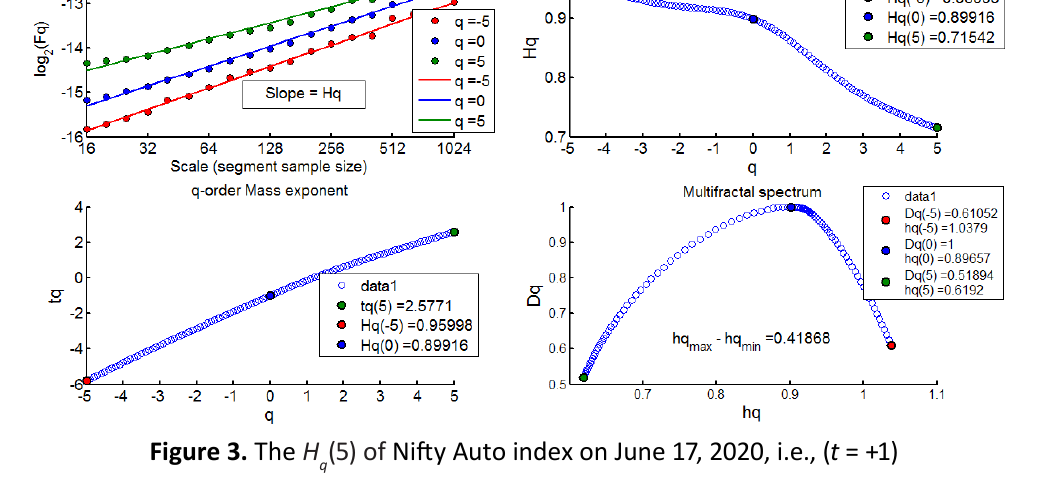
(5) of Nifty Auto index on June 17, 2020, i.e., ( t = +1) Figure 3. The H q